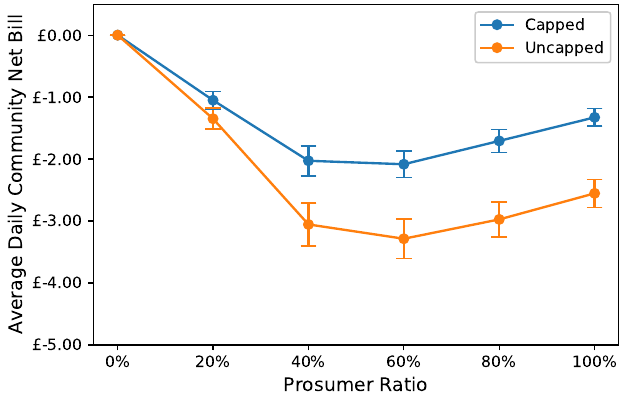
and B C for the setting with imperfect predictions without storage. Figure 9. Average daily (cid:99) B C K K Both average daily (cid:99) B C and B C are negative, which indicate surplus states. However, B C K K all prosumer ratios due to the uncapped approach. The error bars represent 95% confidence